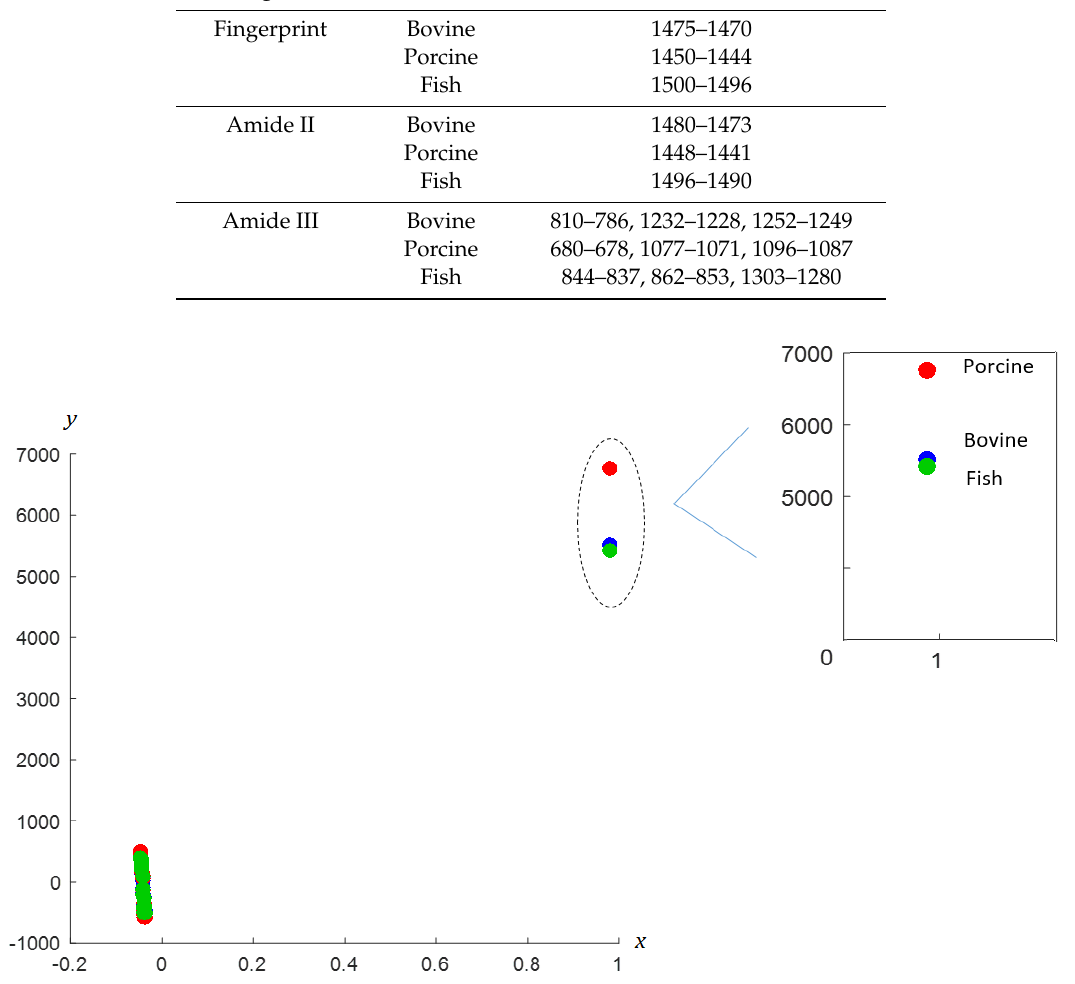
Figure 4. Coordinated FACS of bovine, porcine and fish gelatins.